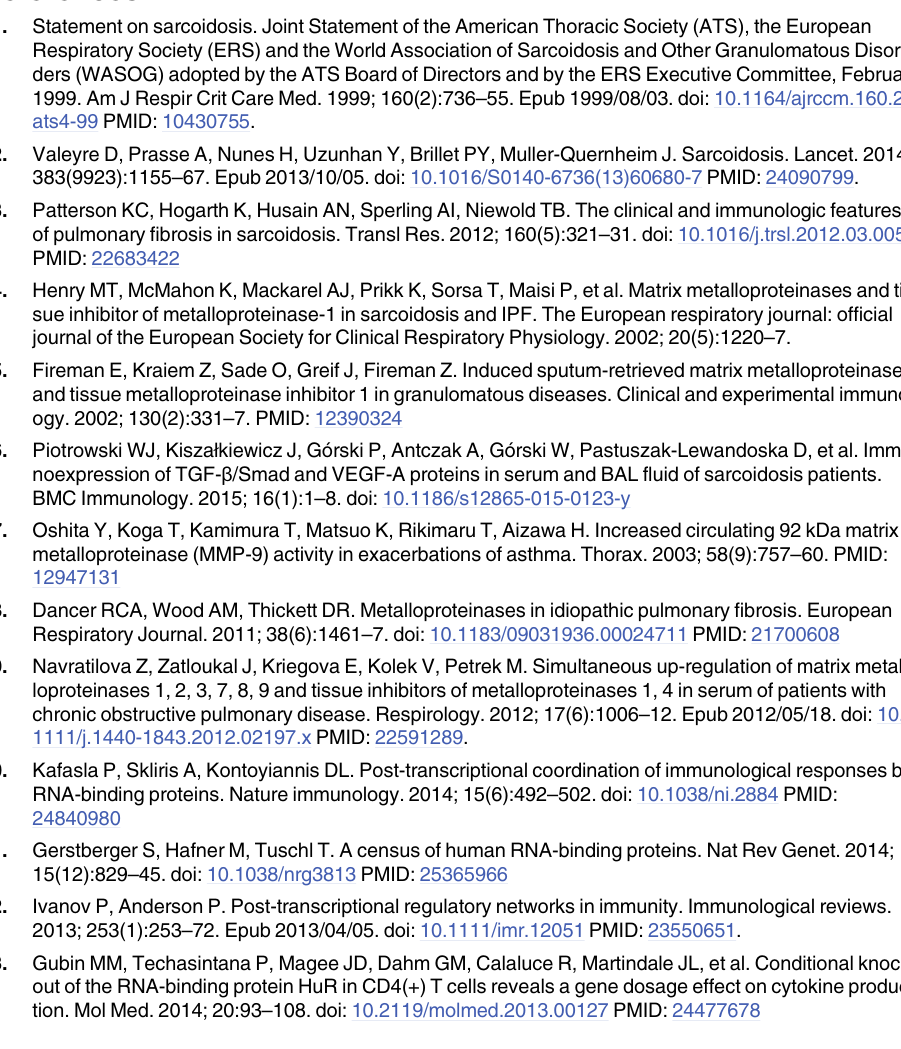
S4 Table. Comparisons of mRNA expression for RNA-binding proteins (RBPs) and one inhibitor of proteolytic activity (RECK) between healthy controls and patient groups including chronic obstructive pulmonary disease (COPD), asthma and idiopathic intersti- tial pneumonias